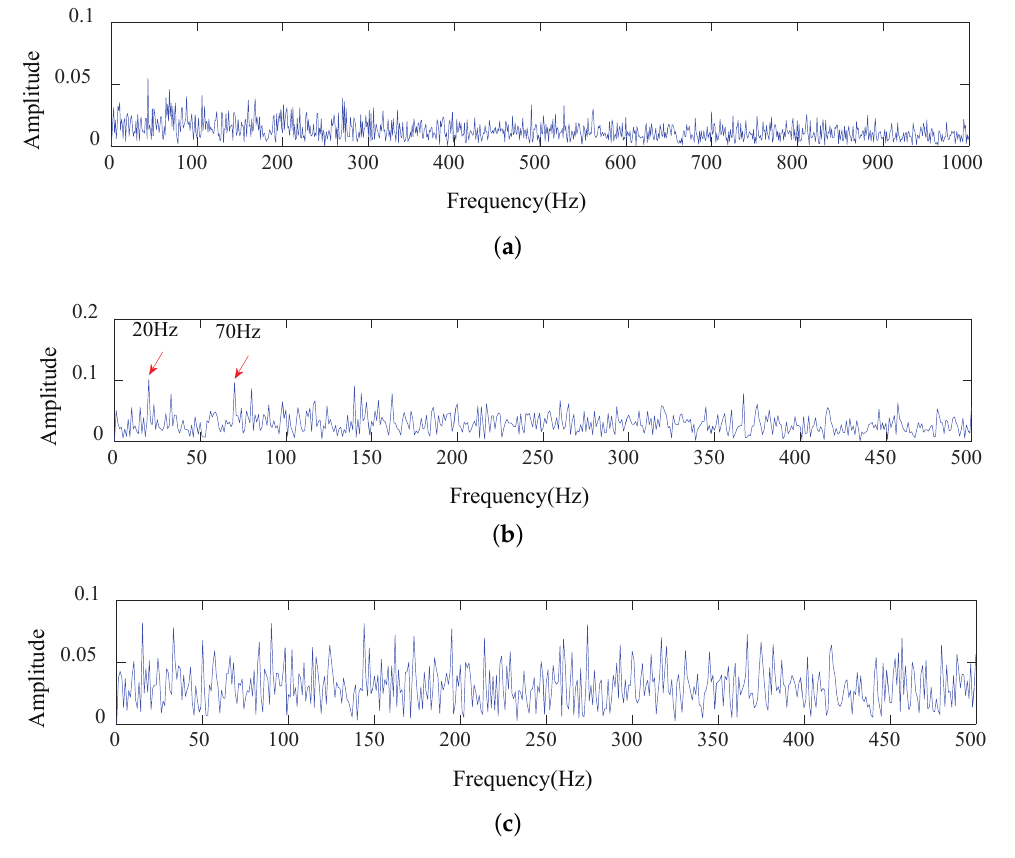
Figure 9. Envelope spectra of the decomposed signals: ( a ) High oscillatory component. ( b ) Low oscillatory component. ( c ) Residual component. Table 1. Comparison of R f and T f of four